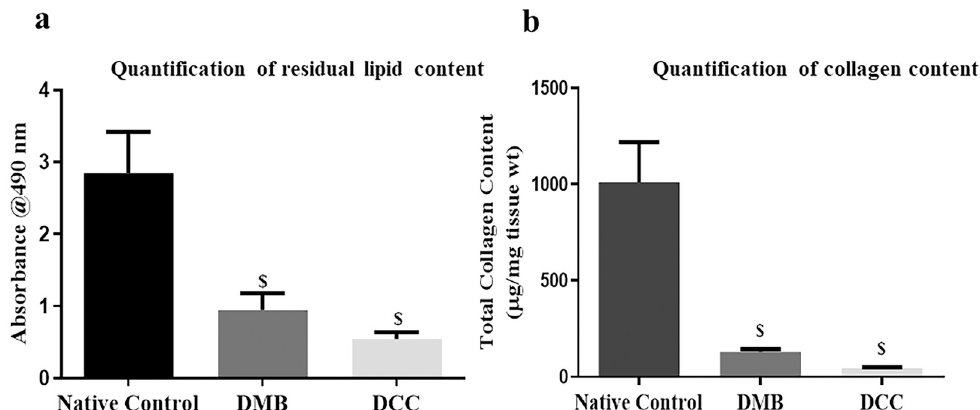
Fig 4. (a). Lipid quantification in scaffolds. Quantification of residual lipids by Oil Red O staining in DMB and DCC scaffolds compared to native control. Values are expressed as mean ± SEM (n = 6). Statistically significant difference of $ p < 0.05. (b). Quantification of total collagen content in DMB and DCC scaffolds. A significant reduction was observed in total collagen content in both DMB and DCC scaffolds compared to native control. Values are expressed as mean ± SEM (n = 6; $ p <